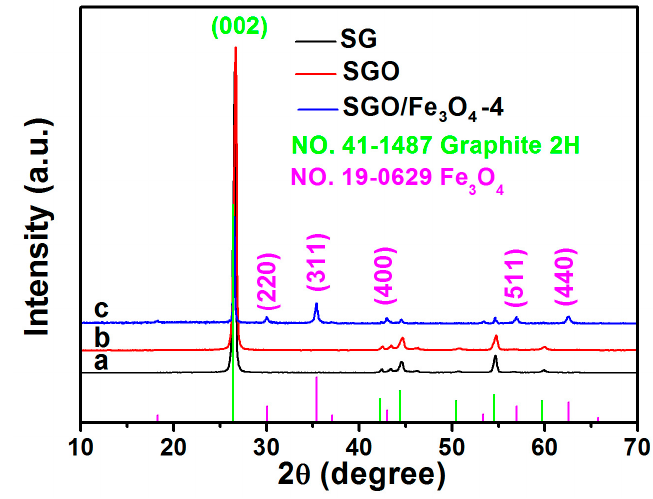
Figure 2. XRD patterns of ( a ) SG, ( b ) SGO, and ( c ) SGO / Fe 3 O 4 -4 composite.